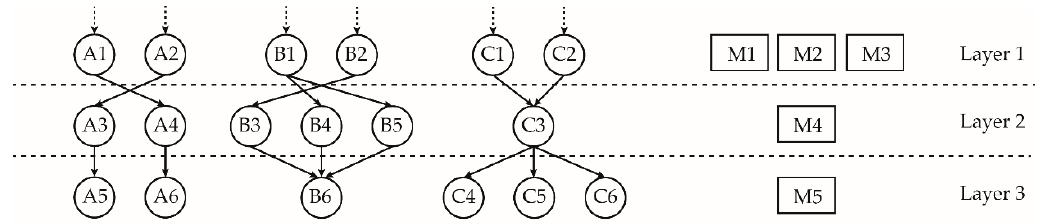
Figure 2. Hierarchical diagram of the multi-DAG task nodes and shared resources.